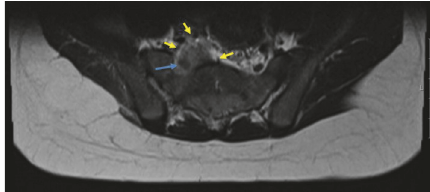
Figure 2: Axial T2-weighted MRI reveals anterior mass extension into the paraspinous soft tissues (yellow arrows), involving the sciatic nerve (blue arrow), which is